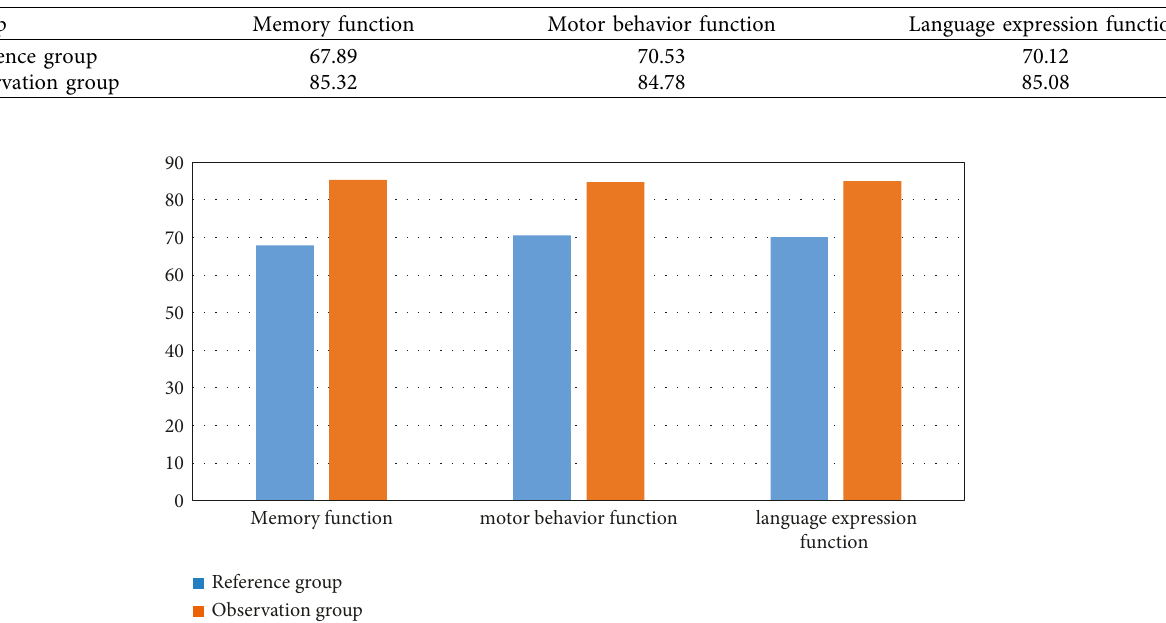
Figure 1: Visualization of blood lipid levels Table 2: Analysis of cognitive function (%).